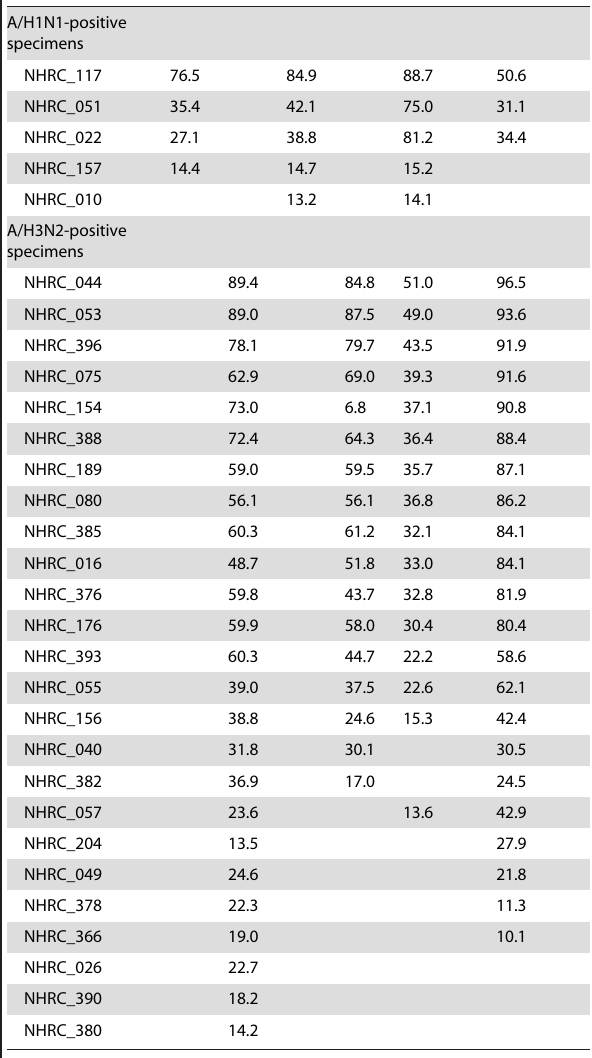
Table 4. RPM-Flu assay results C3 scores of six detector tiles for detection and identification of A/H1N1 and A/H3N2 influenza virus